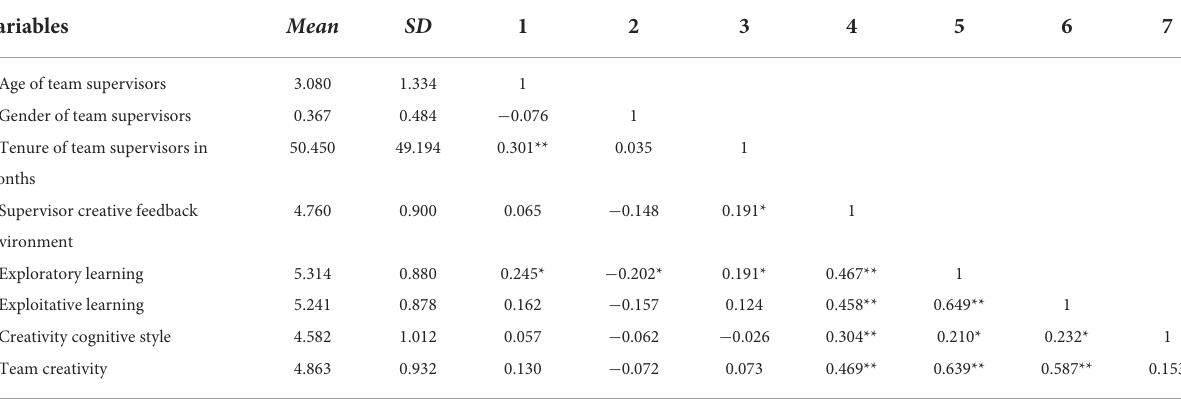
TABLE 2 Descriptive analysis and correlation coefficient of